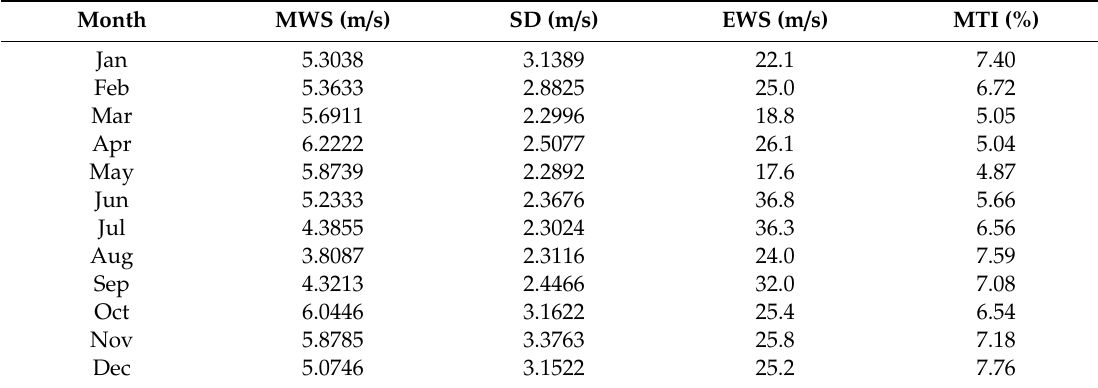
Table 5. Monthly parameters of observed wind speeds. Table 4. Annual and seasonal parameters of observed wind speeds.